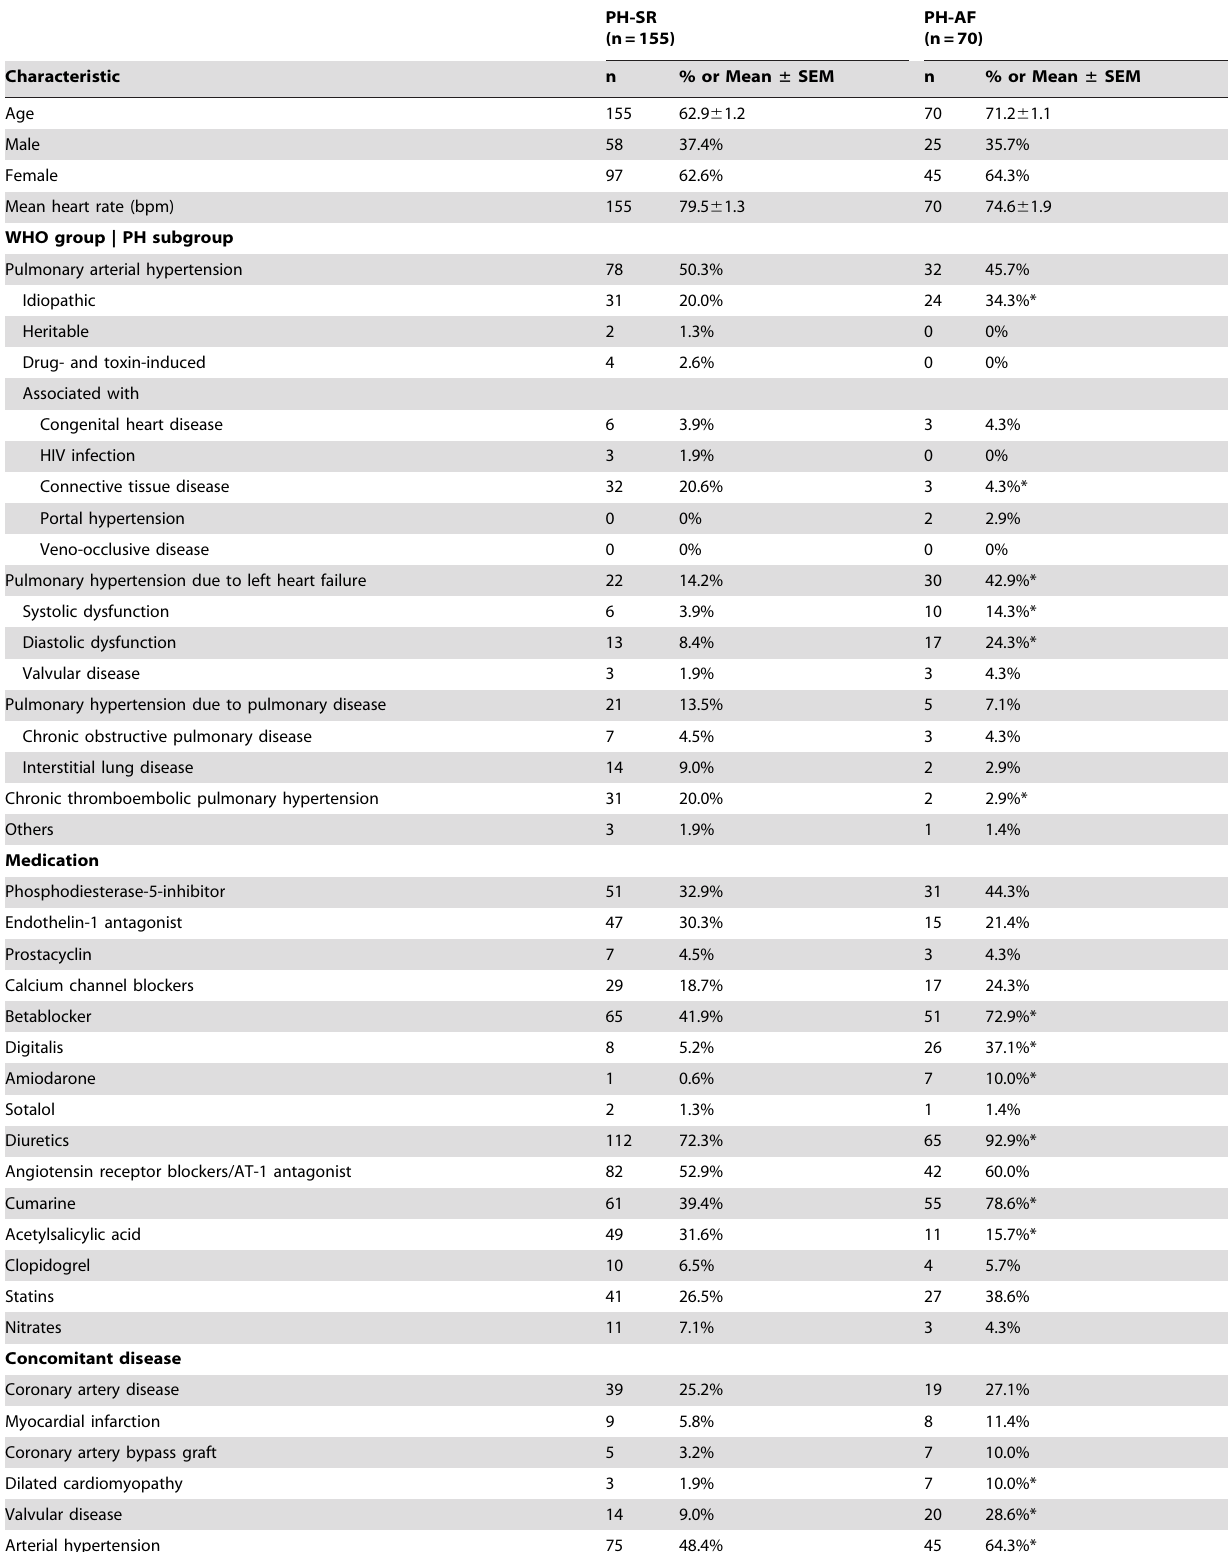
Table 1. Patients’